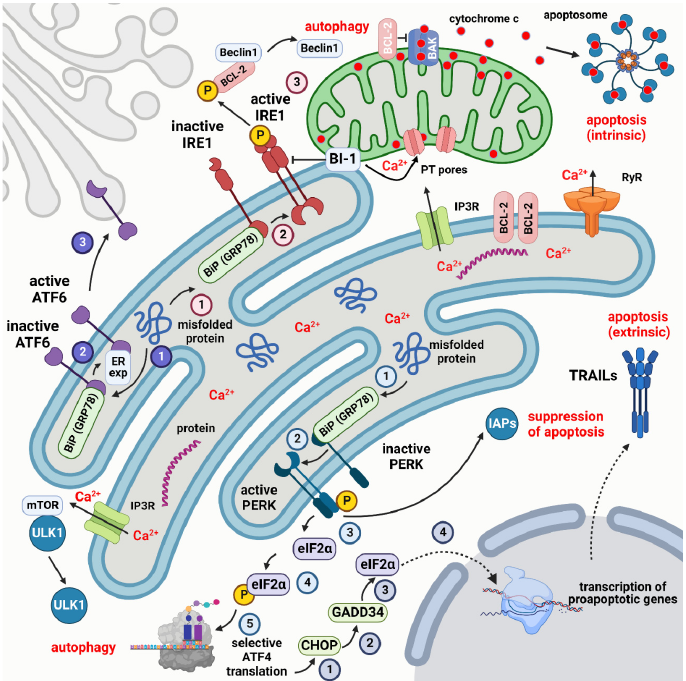
Figure 1. Simplified scheme of the UPR response and its relation to autophagy and apoptosis. The three main sensors that regulate the UPR are PERK, IRE1, and ATF6. Their respective pathways are indicated by numbered circles in light blue, dark blue, and pink. PERK, IRE1, and ATF6 are main ‐ tained in an inactive state by binding to the chaperone BiP (GRP78). Misfolded proteins promote the dissociation of BiP (GRP78) and the activation of the three sensors. Active PERK, in turn, phos ‐ phorylates eIF2 α to start the selective translation of autophagic proteins by ATF4. ATF4 can also activate CHOP that acts on GADD34 to dephosphorylate eIF2 α promoting the transcription of proapoptotic genes among which TRAILs that activate extrinsic apoptosis. Active PERK can, how ‐ ever, inhibit apoptosis by binding to IAPs. Once freed from BiP (GRP78), IRE1 dephosphorylates cytoplasmic BCL ‐ 2 to release Beclin1 and trigger autophagy. The dissociation of ATF6 from BiP (GRP78) leads to binding to an ER export motif that starts the translocation of ATF6 to the Golgi apparatus. The MAM protein BI ‐ 1 controls the Ca 2+ uptake in mitochondria and intrinsic apoptosis, with the intervention of the pro ‐ (BAK, BAX) and antiapoptotic proteins (BCL ‐ 2) of the BCL ‐ 2 fam ‐ ily. Created with Biorender.com (www.biorender.com, accessed on 27 November